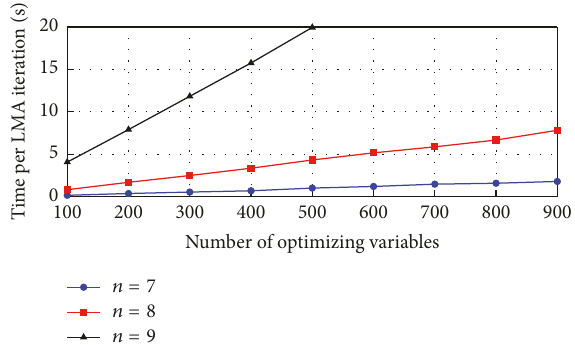
Figure 3: Computing time per LMA iteration depending on the number of optimizing variables and far field resolution for UV grids with 2 𝑛 × 2 𝑛